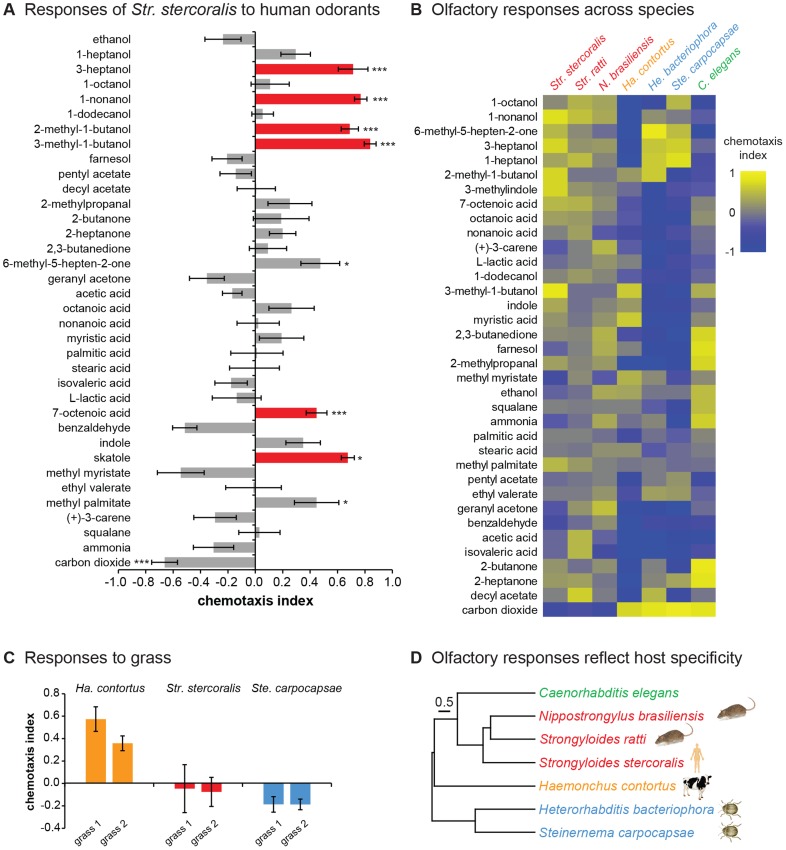
Olfactory responses of mammalian-parasitic nematodes.
A. Str. stercoralis is attracted to a number of human-emitted odorants. Red = attractants for Str. stercoralis that also attract anthropophilic mosquitoes [31], [52]–[58]. n = 6–23 trials per odorant. Str. stercoralis did not respond to the chemotaxis controls (Figure S3). *, P<0.05; ***, P<0.001 relative to control, t-test (CO2 vs. air and L-lactic acid vs. H2O) or one-way ANOVA with Bonferroni post-test (all other odorants vs. paraffin oil). B. Olfactory responses across species. Response magnitudes are color-coded according to the scale shown to the right of the heat map, and odorants are ordered based on hierarchical cluster analysis. n = 6–14 trials for each odorant-species combination. Each species exhibited a unique odor response profile (P<0.0001, two-way ANOVA with Tukey's post-test). Data for responses of EPNs and C. elegans to 10% CO2 are from Dillman et al., 2012 [22]. Red = skin-penetrating; gold = passively ingested; blue = insect-parasitic; green = free-living. C. Responses of Ha. contortus to grass odor. Responses to the odors of two different grass samples were examined. n = 8–17 trials for each sample. D. Olfactory preferences reflect host specificity rather than phylogeny. The behavioral dendrogram was constructed based on the odor response profiles of each species. Hierarchical cluster analysis was performed using UPGMA (Unweighted Pair Group Method with Arithmetic Mean). Euclidean distance was used as a similarity measure. Hosts (humans, ruminants, rodents, or insects) for each species are indicated. Coph. Corr. = 0.96. For all graphs, error bars indicate SEM.